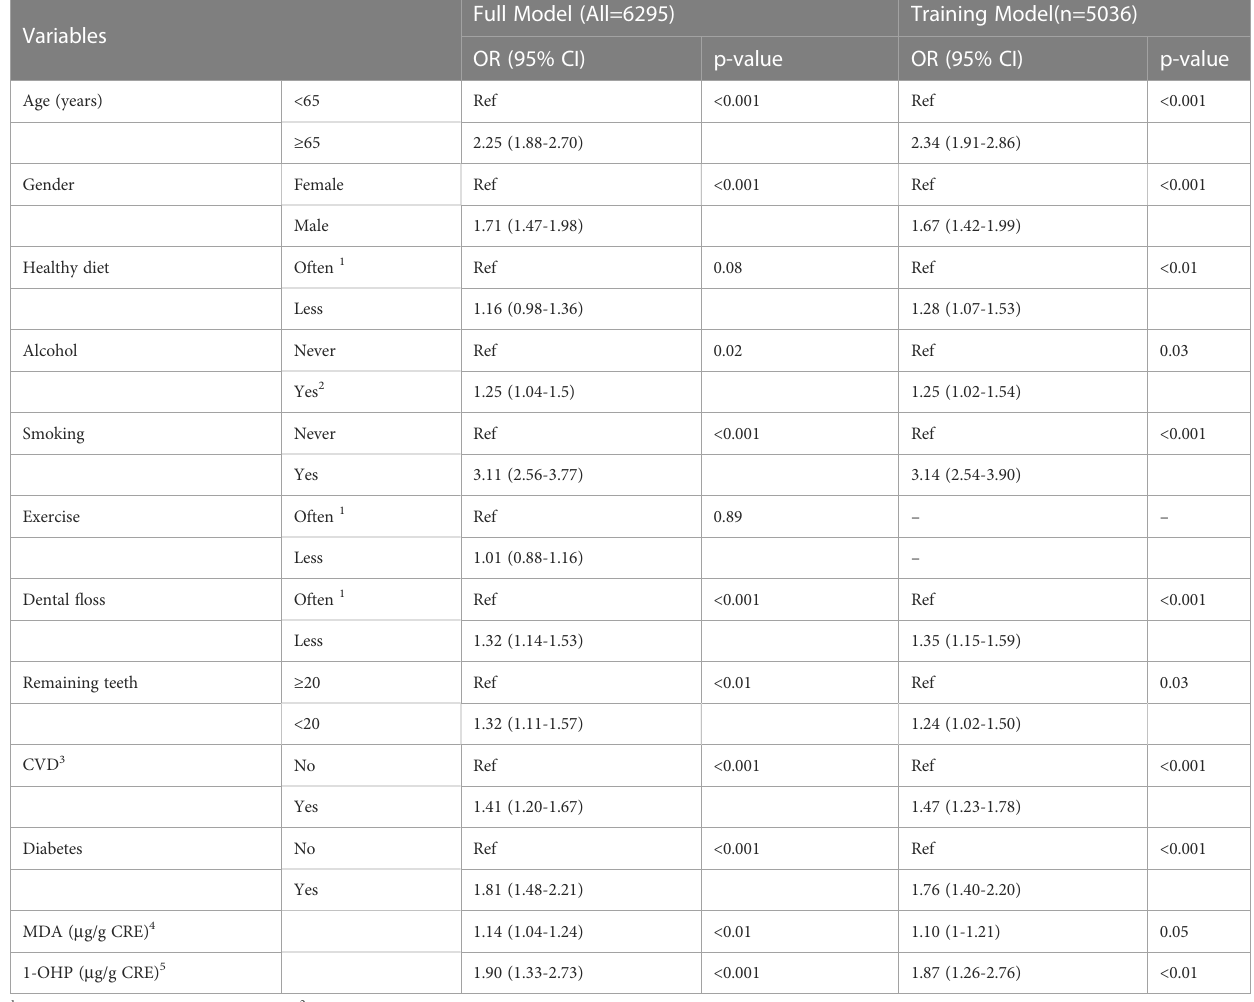
TABLE 2 Logistic regression analysis of factors associated higher serum level of CEA 6